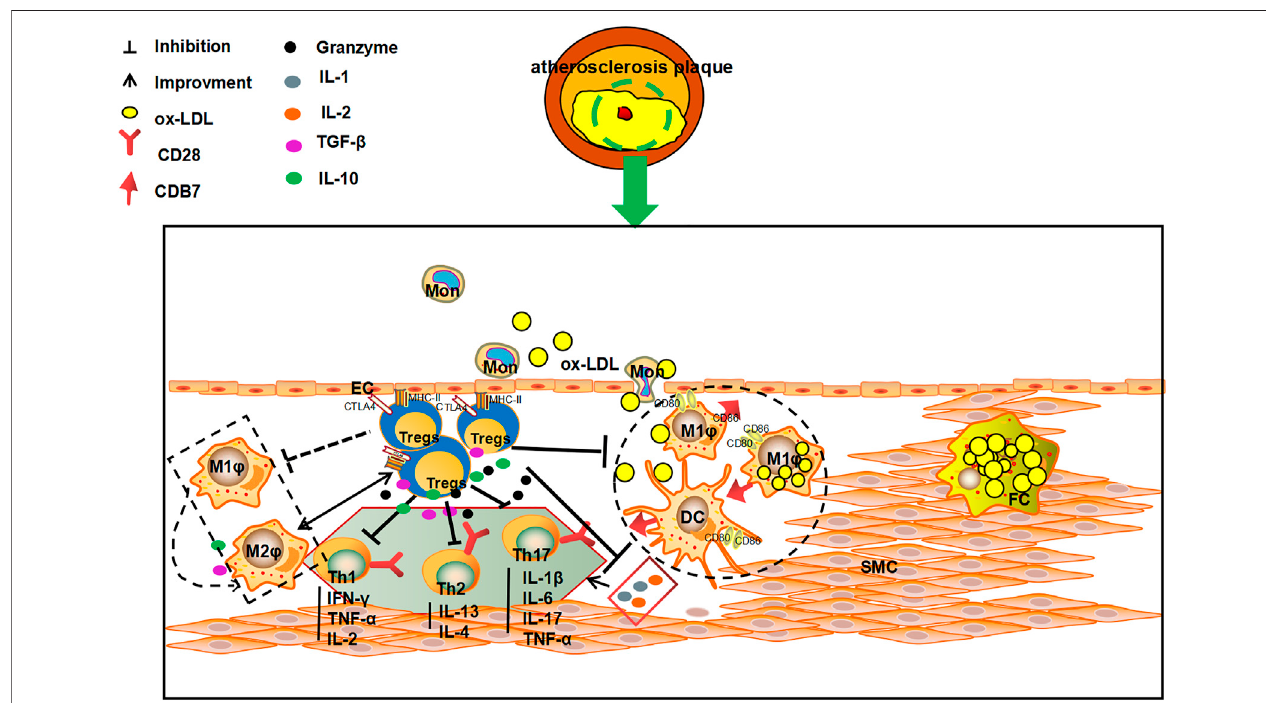
FIGURE 2 | The multiple anti-AS mechanisms of Tregs. Tregs can kill effector T cells via direct contact with T cells, and inhibit the secretion of pro-in fl ammatory cytokines and the production of immunosuppressive enzymes by secreting TGF- β and IL-10. Tregs can also 1) inhibit the secretion of IL-1 and IL-2 to in fl uence the proliferation of effector T cells by secreting TGF- β and IL-10; 2)suppress the secretion of IFN- γ , TNF- α and IL-4 by Th1 and Th2 cells; and 3) reduce the expression of MHC II on DC and macrophages membrane, and affect the stimulation of CD28/B7 pathway on T cells, and consequently play an important role in inhibiting, slowing down the process of AS and increasing the stability of